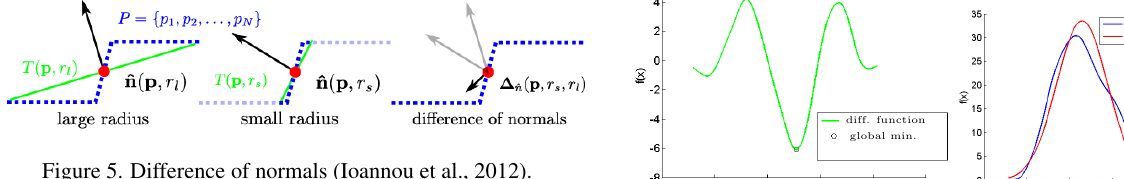
tional feature. Figure 7 illustrates a PDF and its approximated normal distribution together with the resulted difference function and the according global minimum.